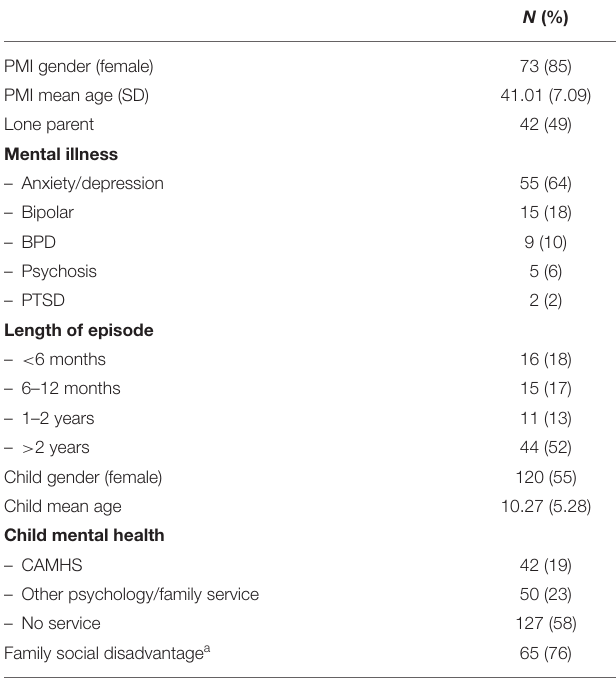
TABLE 1 | Characteristics of families in RCT ( N =